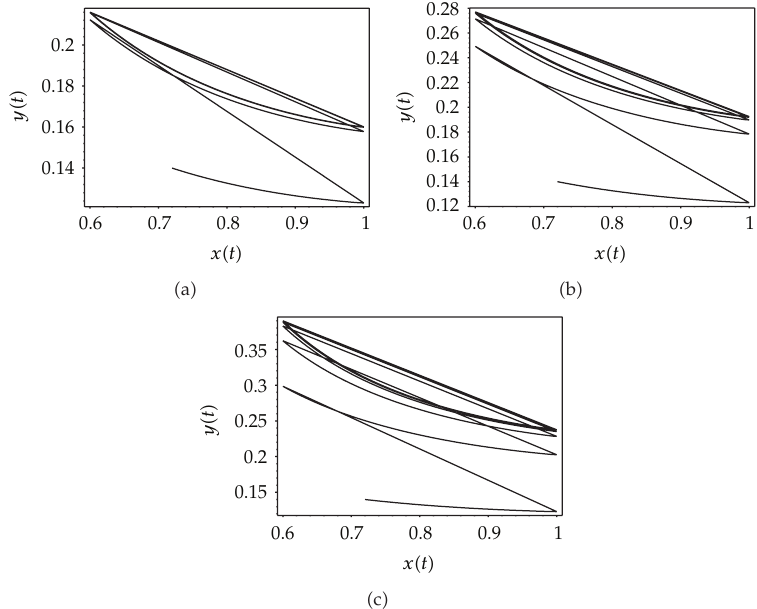
Figure 13: The phase portraits of system (cid:6) 1.3 (cid:7) with x 0 (cid:8) 0 . 72, y 0 (cid:8) 0 . 114, p (cid:8) 0 . 4, ι (cid:8) 0 . 62, and di ff erent q : (cid:6) a (cid:7) q (cid:8) 0 . 9; (cid:6) b (cid:7) q (cid:8) 0 . 6; (cid:6) c (cid:7) q (cid:8) 0 .